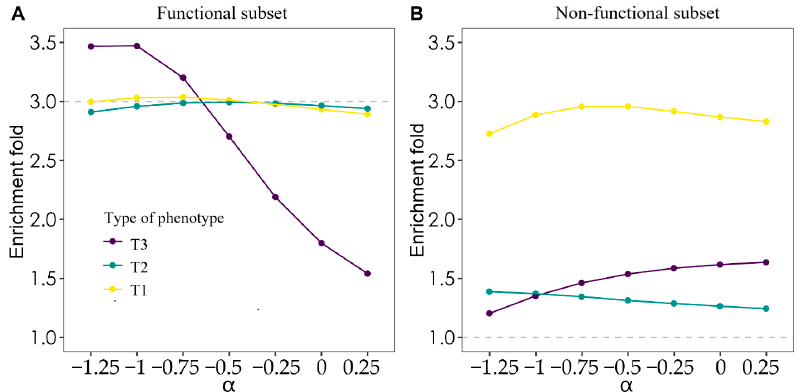
Figure 2. Comparison of performance of different α values for α -model. Showing the estimated enrichments of different α values for α -models integrated with ( A ) “Functional subset” or ( B ) “Non- functional subset”. The different color and dotted lines are explained as in Figure 1.